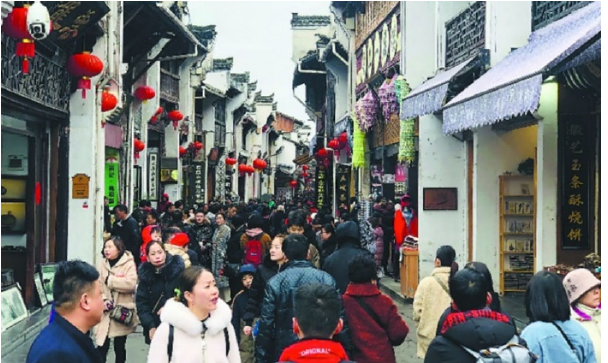
Figure 14. Cultural heritage promotes tourism and the economic development of the town